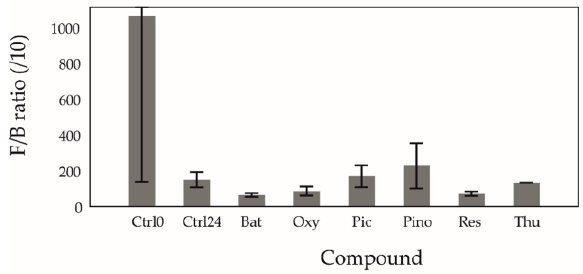
Figure 2. Mean Firmicutes/Bacteroidetes ratio (/10) in fermentations. Error bars represent the 95% CI. Ctrl0 = control at 0 h; Ctrl24 = control at 24 h; Bat = batatasin III; Oxy = oxyresveratrol; Pic = piceatannol; Pino = pinostilbene; Res = trans -resveratrol; Thu = thunalbene. All stilbenoids at 24 h.